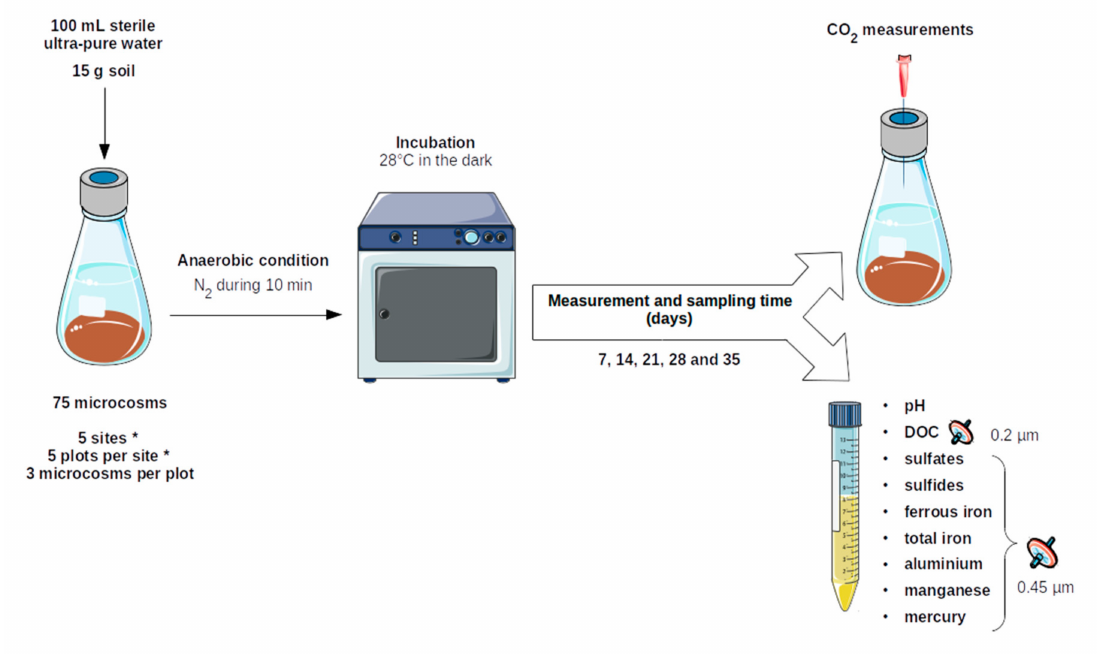
Figure 2. Description of the experimental set-up. First, preparation of the culture media in microcosms, then flushing with N 2 to switch to anaerobic conditions. Incubation in the dark at 28 ◦ C for 35 days. Before each sampling, CO 2 measurements are carried out, then the culture medium is taken with a syringe, and the different parameters are